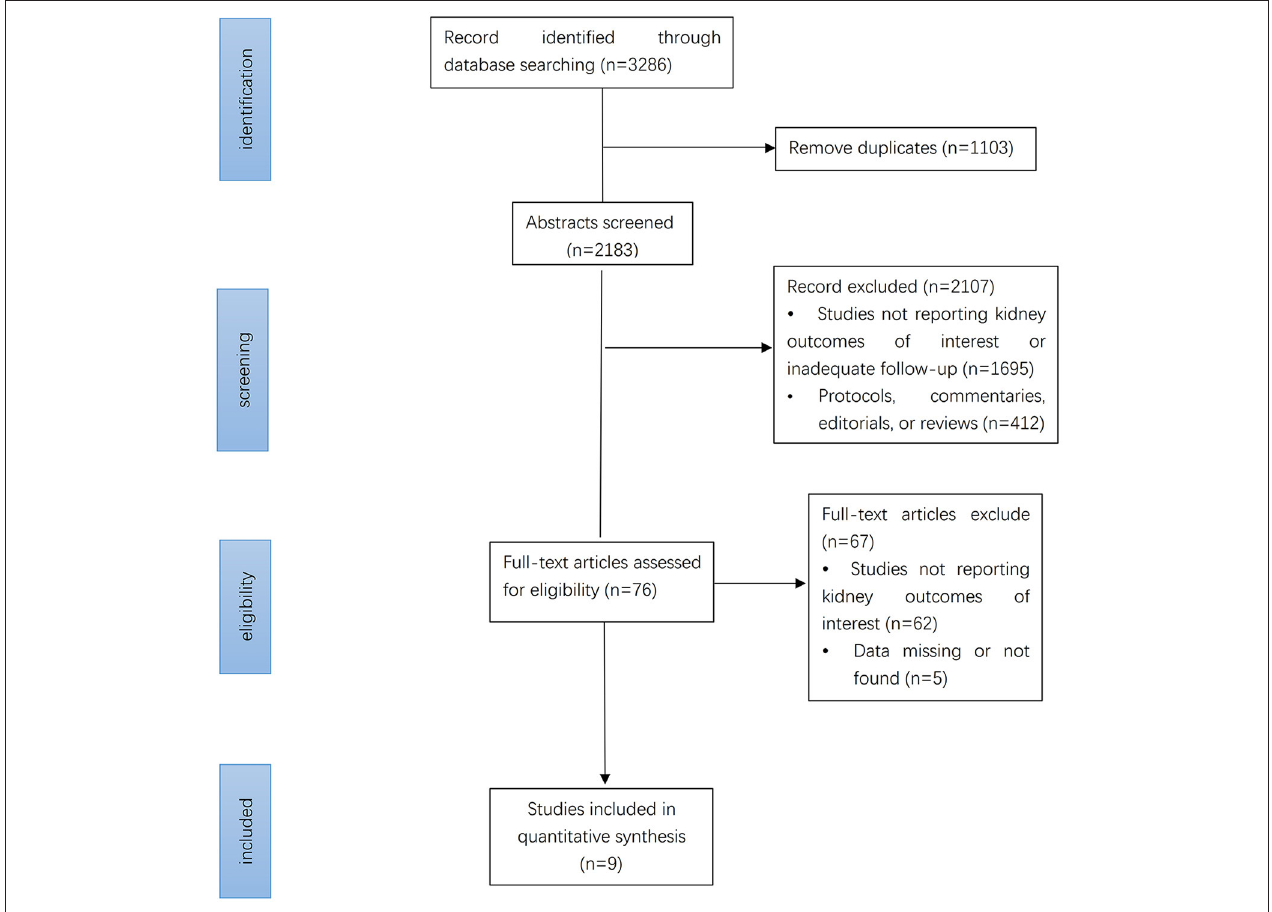
FIGURE 1 | Identification of eligible studies: flow